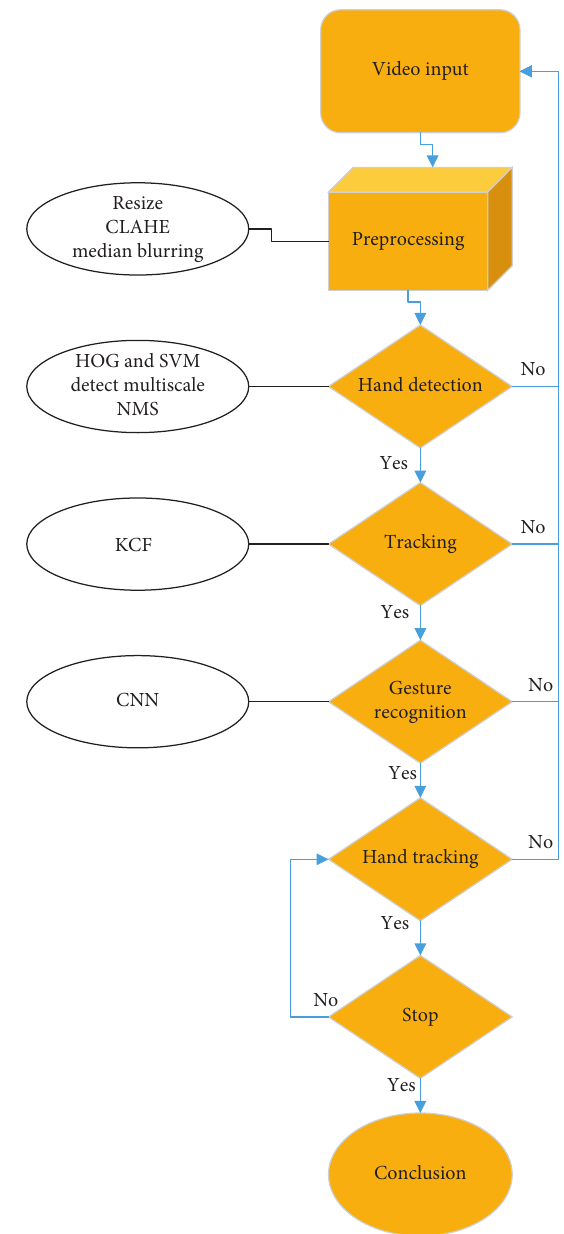
Figure 7: Proposed gesture recognition